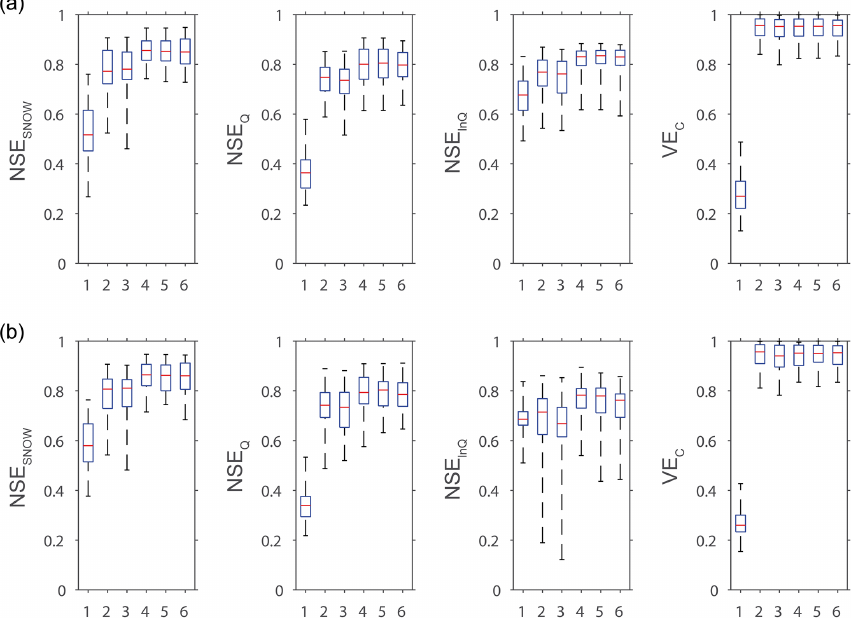
Figure 6. Boxplots (showing 0.00, 0.25, 0.50, 0.75, and 1.00 percentiles) of the efficiency distributions obtained in validation by the (a) GR4J and (b) HBV9 models combined with the snow model according to six different tests (see Table 5) to account for elevation dependency in the T and P inputs on the 20 snow-affected Alpine catchments. Table 6. Mean validation efficiency of the six modelling tests (see Table 5) on the set of 20 catchments with the GR4J model and the HBV9 model. Model